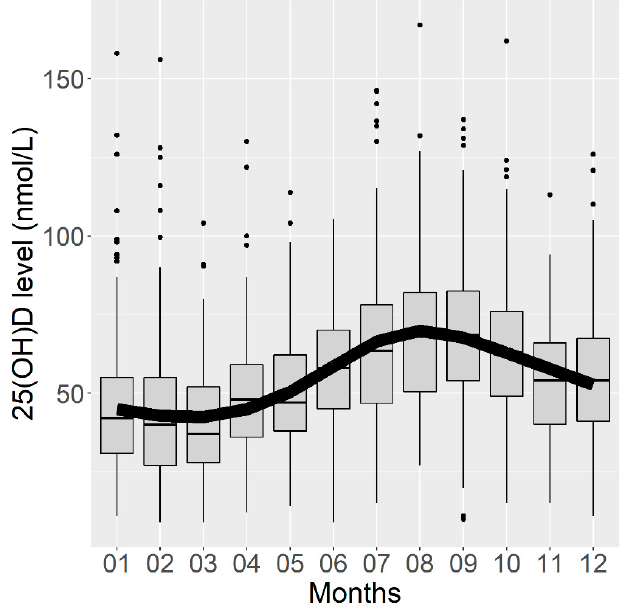
Figure 2. Box plots representing serum vitamin D concentrations according to the month of blood sampling and curve of vitamin D concentrations predicted by a linear regression model using a cyclic cubic spline. Table 2. Corrected R 2 of the bivariable models adjusted to the month of the blood sampling.